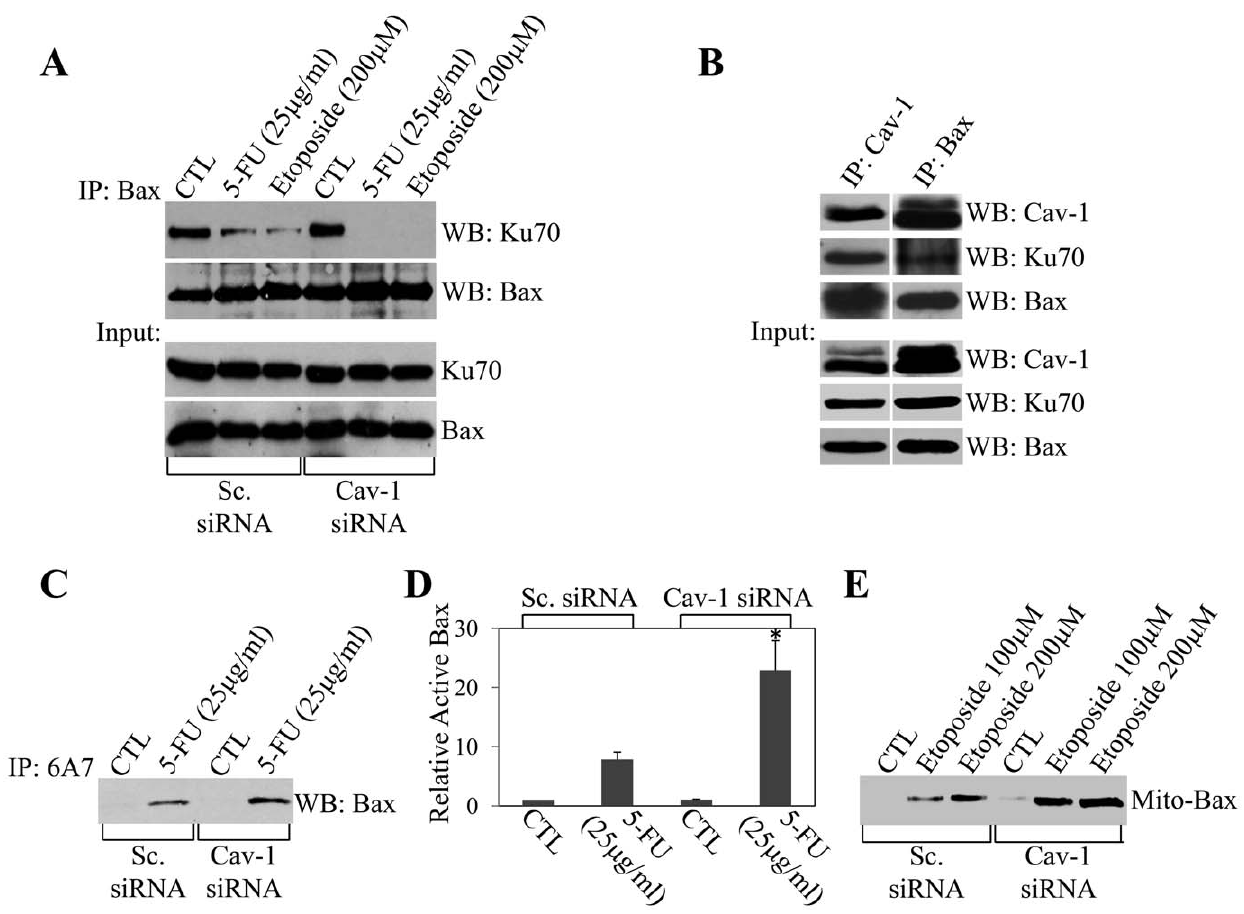
Figure 5. Knockdown of caveolin-1 protein expression enhances the dissociation of Bax from Ku70 and the activation of Bax induced by chemotherapeutic drugs. (A, C, D and E) HCT116 colon cancer cells were transfected with siRNA directed against caveolin-1. Transfection with scrambled siRNA was used as control. One day after transfection, HCT116 cells were treated with either 5-FU (A, C and D) or etoposide (A and E) for 24 hours. In (B), untransfected cells were treated with 5-FU for 24 hours. In (A), cell lysates were immunoprecipitated with an antibody probe specific for Bax and immunoprecipitates subjected to Western blotting analysis with anti-Ku70 and anti-Bax IgGs. In (B), cell lysates were immunoprecipitated with either anti-caveolin-1 IgGs or anti-Bax IgGs. Immunoprecipitates were then subjected to immunoblotting analysis with antibody probes specific for caveolin-1, Ku70 and Bax. In (C and D), cell lysates were immunoprecipitated with a Bax (6A7) antibody and immunoprecipitates subjected to immunoblotting analysis with anti-Bax IgGs. A blot that is representative of three independent experiments is shown in (C), quantification of Bax levels pulled down by the Bax (6A7) antibody is shown in (D). Values in (D) represent mean 6 SEM; * P , 0.001. In (E), mitochondrial fractions were isolated and expression of Bax in mitochondria was detected by immunoblotting analysis using an antibody probe specific for Bax.